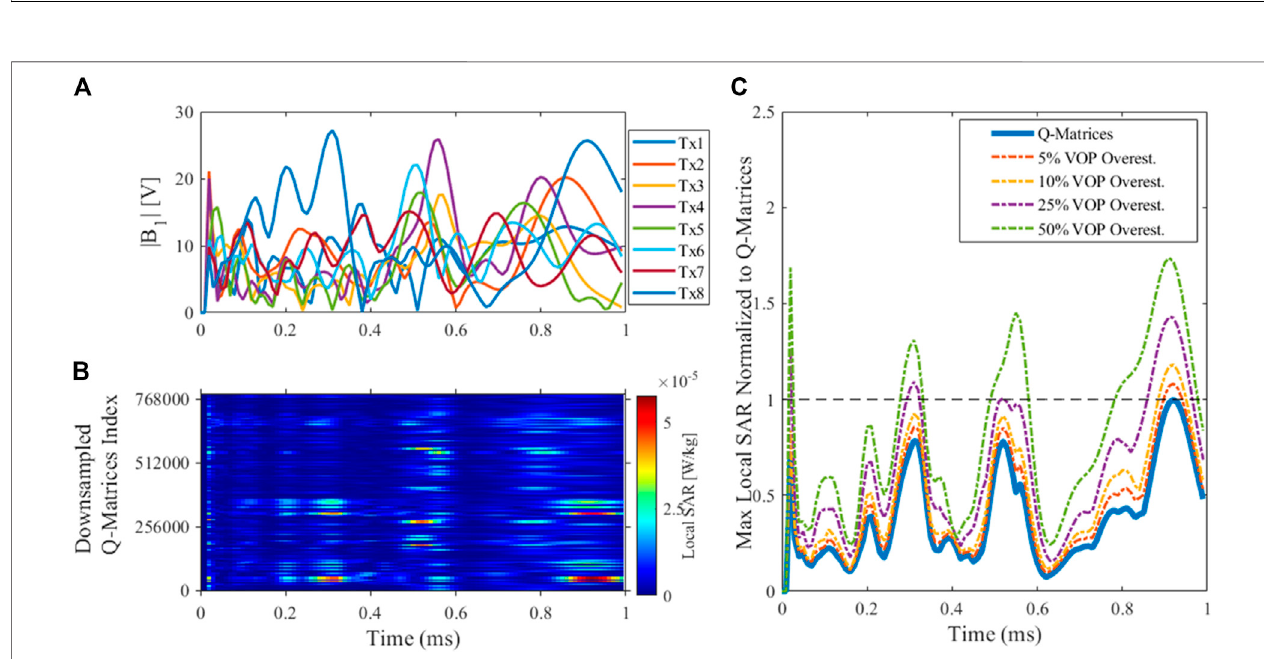
FIGURE 9 | Local SAR for a 5 ° excitation Universal Pulse. (A) UP magnitude waveform; (B) Instantaneous SAR for the UP excitation in MPRAGE using downsampled uncompressed Q-matrices; (C) Max local SAR for each time point of the UP for the Q-matrices and VOPs with 5, 10, 25, and 50% overestimation, all normalized to the maximum of the Q-matrices ’ SAR. Different time points of the UP (i.e., different amplitude and phase con fi gurations) lead to varying levels of VOP overestimation relative to the Q-matrices, but importantly the VOP-derived estimate is always overestimated.